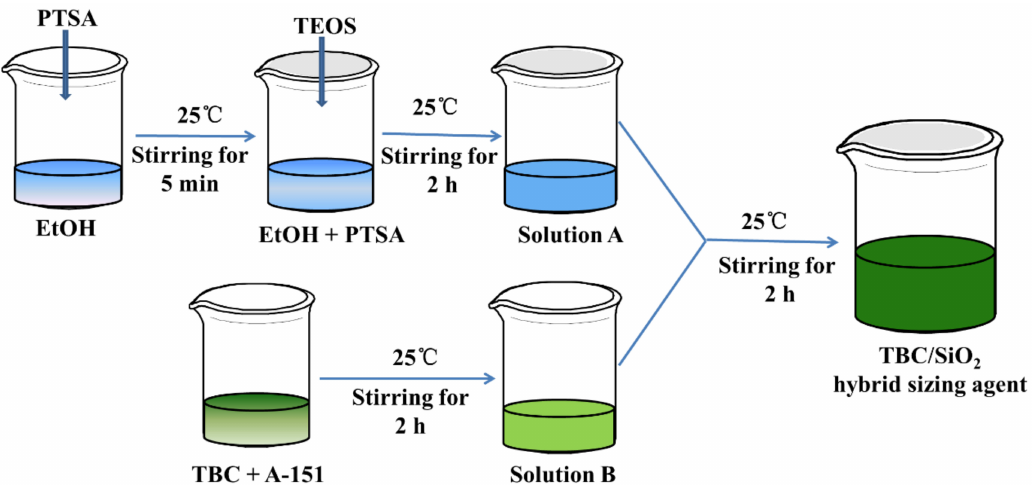
Figure 2. Illustration of the preparation of SiO 2 /TBC hybrid sizing agent.